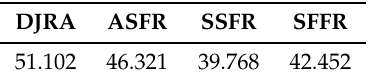
Table 4. Single cell throughput numerical analysis (Mbps).